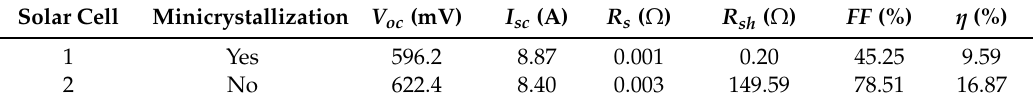
Table 1. Photovoltaic (PV) properties of the two mc-Si solar cells with and without minicrystallization. Solar Cell